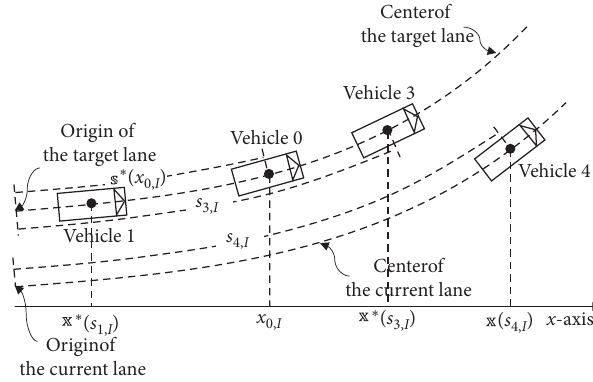
Figure 4: Curve distance-related function